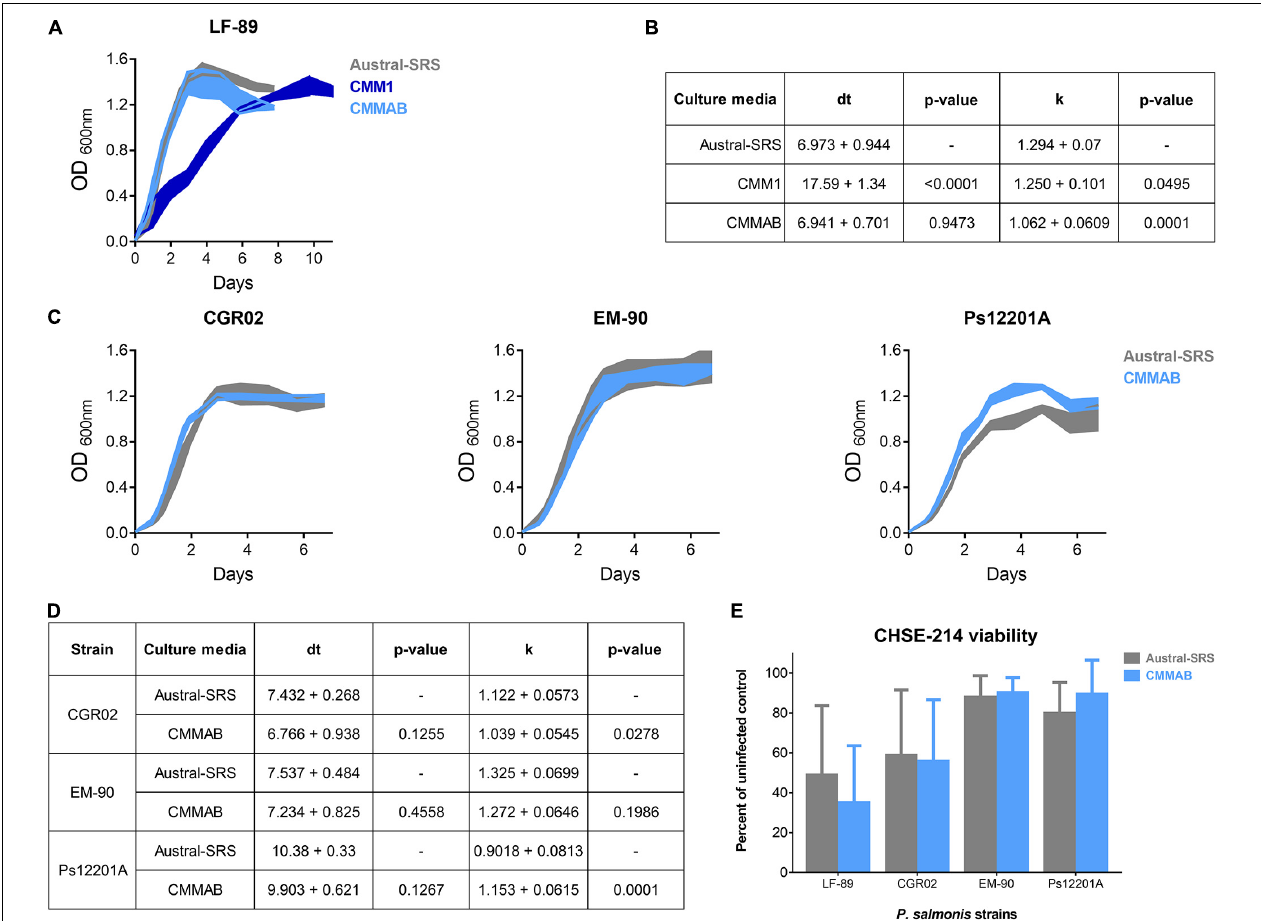
FIGURE 2 | Bacterial infection and growth comparison of different P. salmonis strains in nutrient-rich and in a defined culture media. (A) Growth curves of the reference strain LF-89 in Austral-SRS nutrient medium, CMM1 defined medium and the optimized defined medium CMMAB. (B) The carrying capacity parameter (k) and the maximum doubling time (dt) were obtained by assessing the unrestrained growth of P. salmonis LF-89 in the three media. A t -test was performed to compare the growth curve parameters between the bacteria grown in the CMM1 or in the CMMAB media with the control Austral-SRS medium. (C) Growth curves of P. salmonis strains CGR02, EM-90, and Ps12201A in the control nutrient media and the optimized defined media (Austral-SRS and CMMAB, respectively). (D) Growth curve parameters k and dt of CGR02, EM-90, and Ps12201A strains in Austral-SRS and CMMAB media. A t -test was performed to compare the growth curve parameters between the bacteria grown in CMMAB media and the control Austral-SRS medium. (E) Cell viability MTT assay after infection with P. salmonis strains grown in Austral-SRS (gray bars) or in CMMAB (light blue bars). A two-way ANOVA showed no significant differences between the effect on cell viability (presented as percent viability of uninfected controls) caused by bacteria grown in both media.